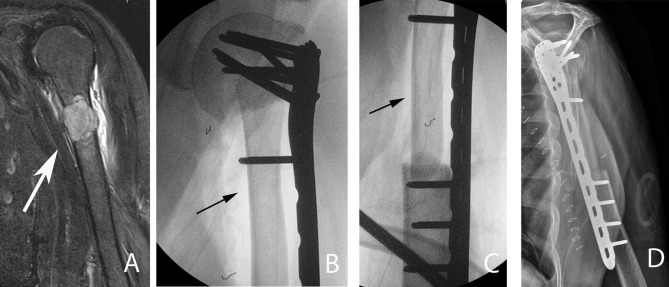
A 54-year-old patient with a left proximal humeral diaphyseal renal cell solitary metastasis treated with wide resection and reconstruction using a fibular allograft and locking plate internal fixation. (A) MRI of left humerus showing a metastatic lesion (arrow). (B,C) Intraoperative fluoroscopic images after intercalary resection of the proximal humerus diaphysis and reconstruction using a fibular strut graft (arrows). (D) Note the preservation of the native humeral head and the locking plate fixation.